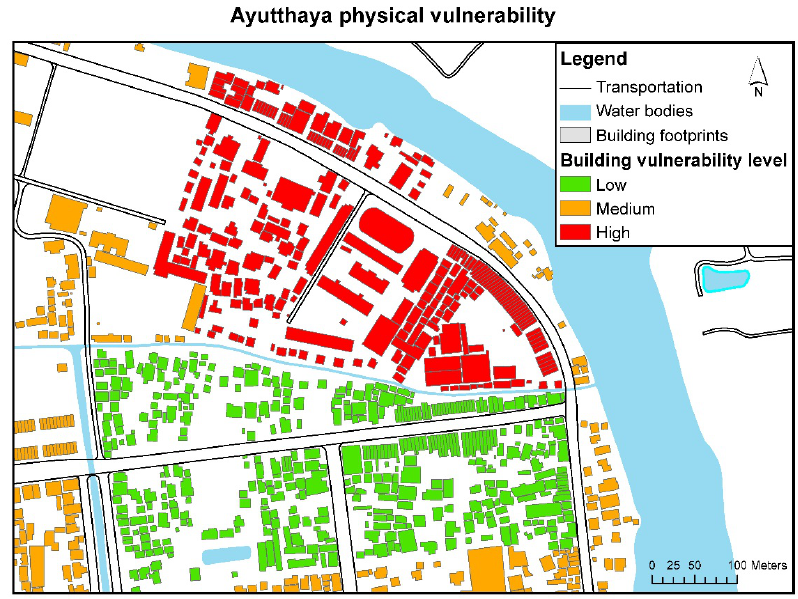
Figure 9. Illustration of the physical vulnerability of the Ayutthaya building stock to flood hazard (details). Categorization based on the type of local architecture and its structural resilience to floods, expressed through pertinent depth-damage functions.